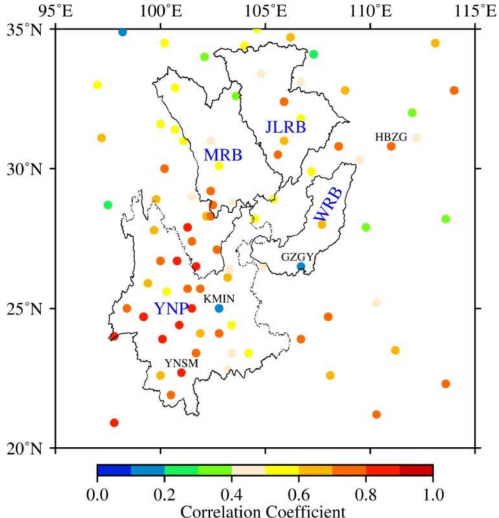
Figure 3. Correlation coe ffi cient between GPS-measured and GRACE-derived vertical displacement time series for each GPS station over the period January 2011 to June 2017. The GRACE-derived vertical displacements are inferred from CSR RL06 GRACE SH solutions (CSR GRACE-SH). The dots represent the distribution of permanent GPS stations, and their colors represent the correlation coe ffi cient values. The locations of YNSM, HBZG, GZGY, and KMIN station are marked, and the abbreviations YNP, MRB, JLRB, and WRB in blue indicate Yunnan Province, Min River Basin, Jialing River Basin, and Wu River Basin,